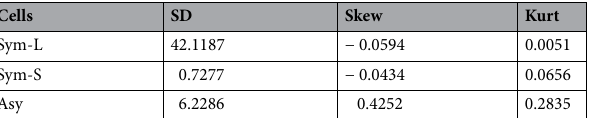
Table 2. Statistical parameters computed for current signals of Sym and Asy copper electrodes in 0.3 M NaCl + 0.3 M Na 2 SO 4 at 60 °C.